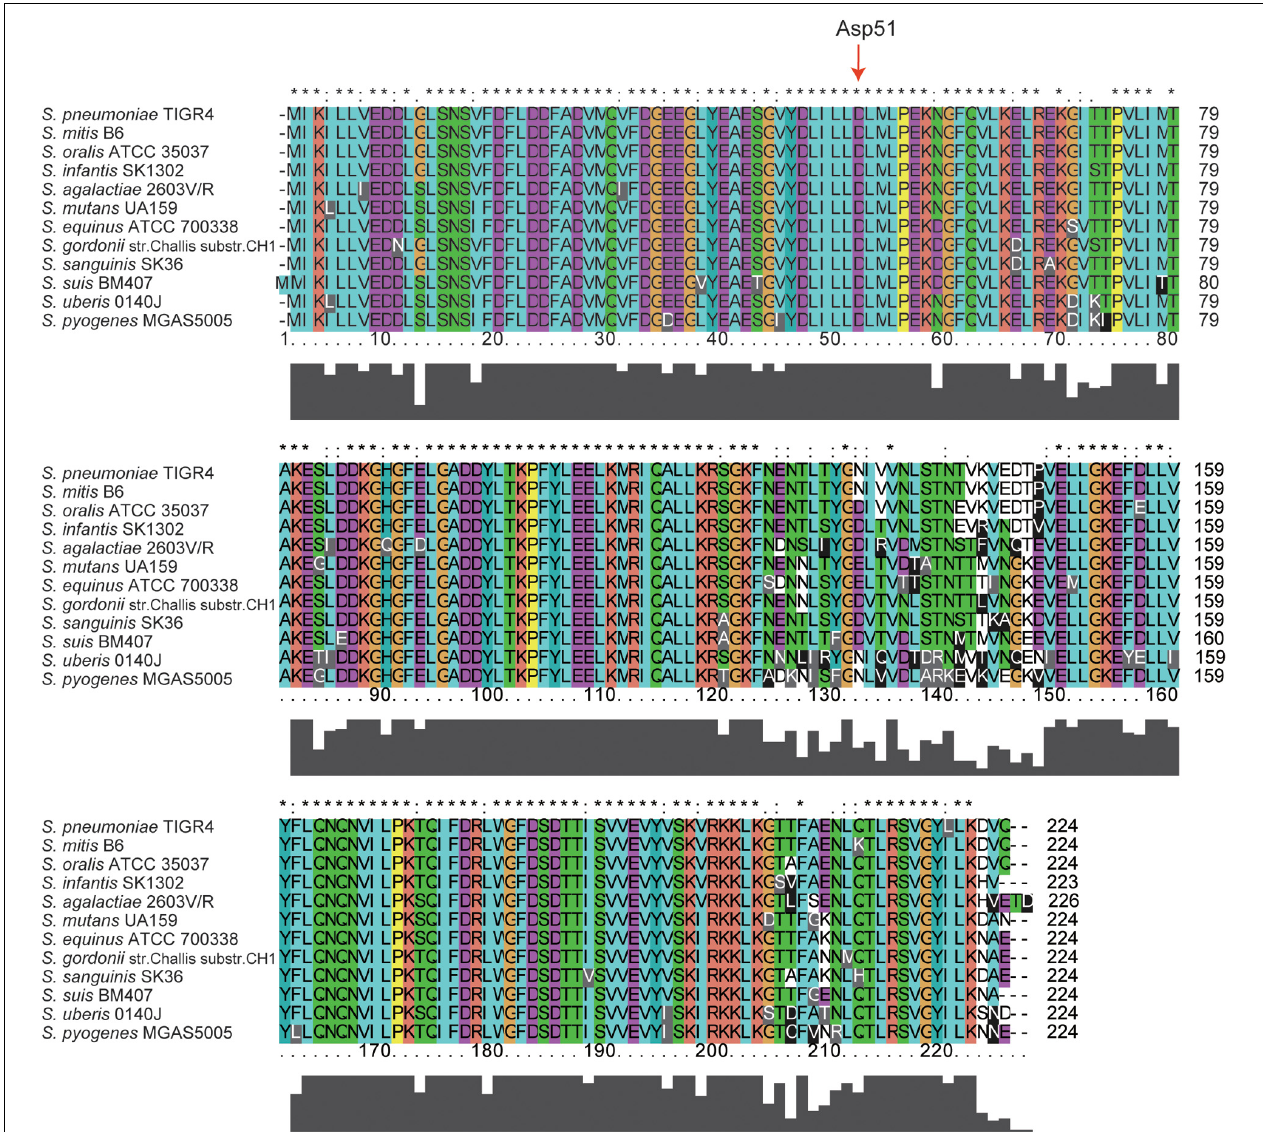
FIGURE 1 | Multiple amino acid sequence alignment of CiaR across 12 streptococcal species. Homologous sequences with 91–100% similarities. The 12 streptococcal species, namely, S. pneumoniae TIGR4, S. mitis B6, S. oralis ATCC 35037, S. infantis SK1302, S. agalactiae 2603V/R, S. mutans UA159, S. equinus ATCC 700338, S. gordonii str. Challis substr. CH1, S. sanguinis SK36, S. suis BM407, S. uberis 0140J, and S. pyogenes MGAS5005. The residues labeled with * represent the invariant residues. The height in the bar graph represents the conservation of amino